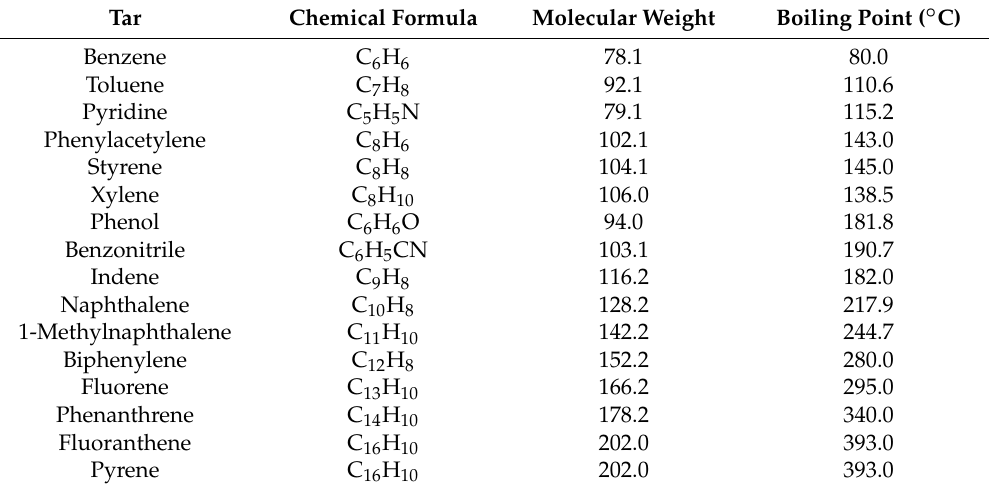
Figure 3. Tar-sampling train (European tar protocol). Table 4. Classification of tar resulting from gasification (C 6 -C 16 ) [15].